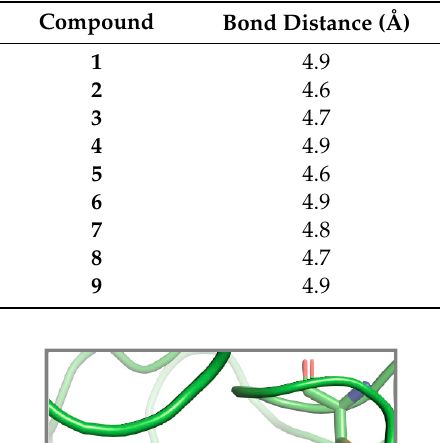
Table 4. Bond distance between α -carbon of all compounds and the sulfur of Cys215, calculated using PyMol 2.0.